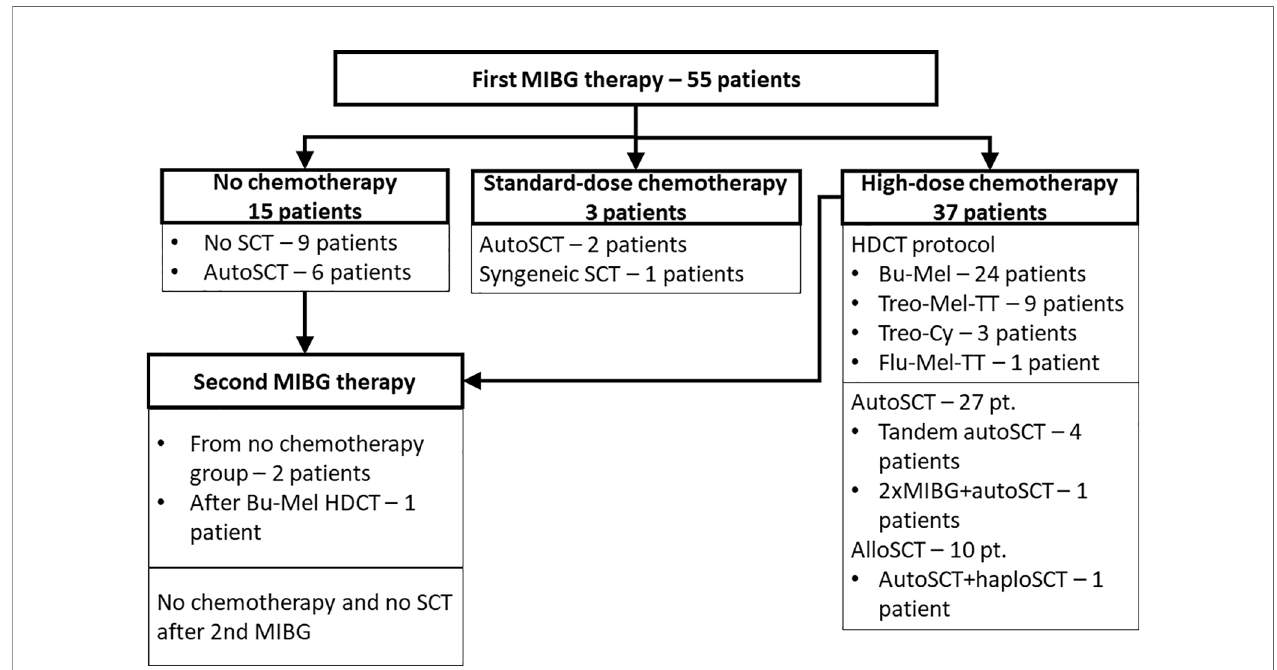
FIGURE 1 | Distribution of patients treated with MIBG